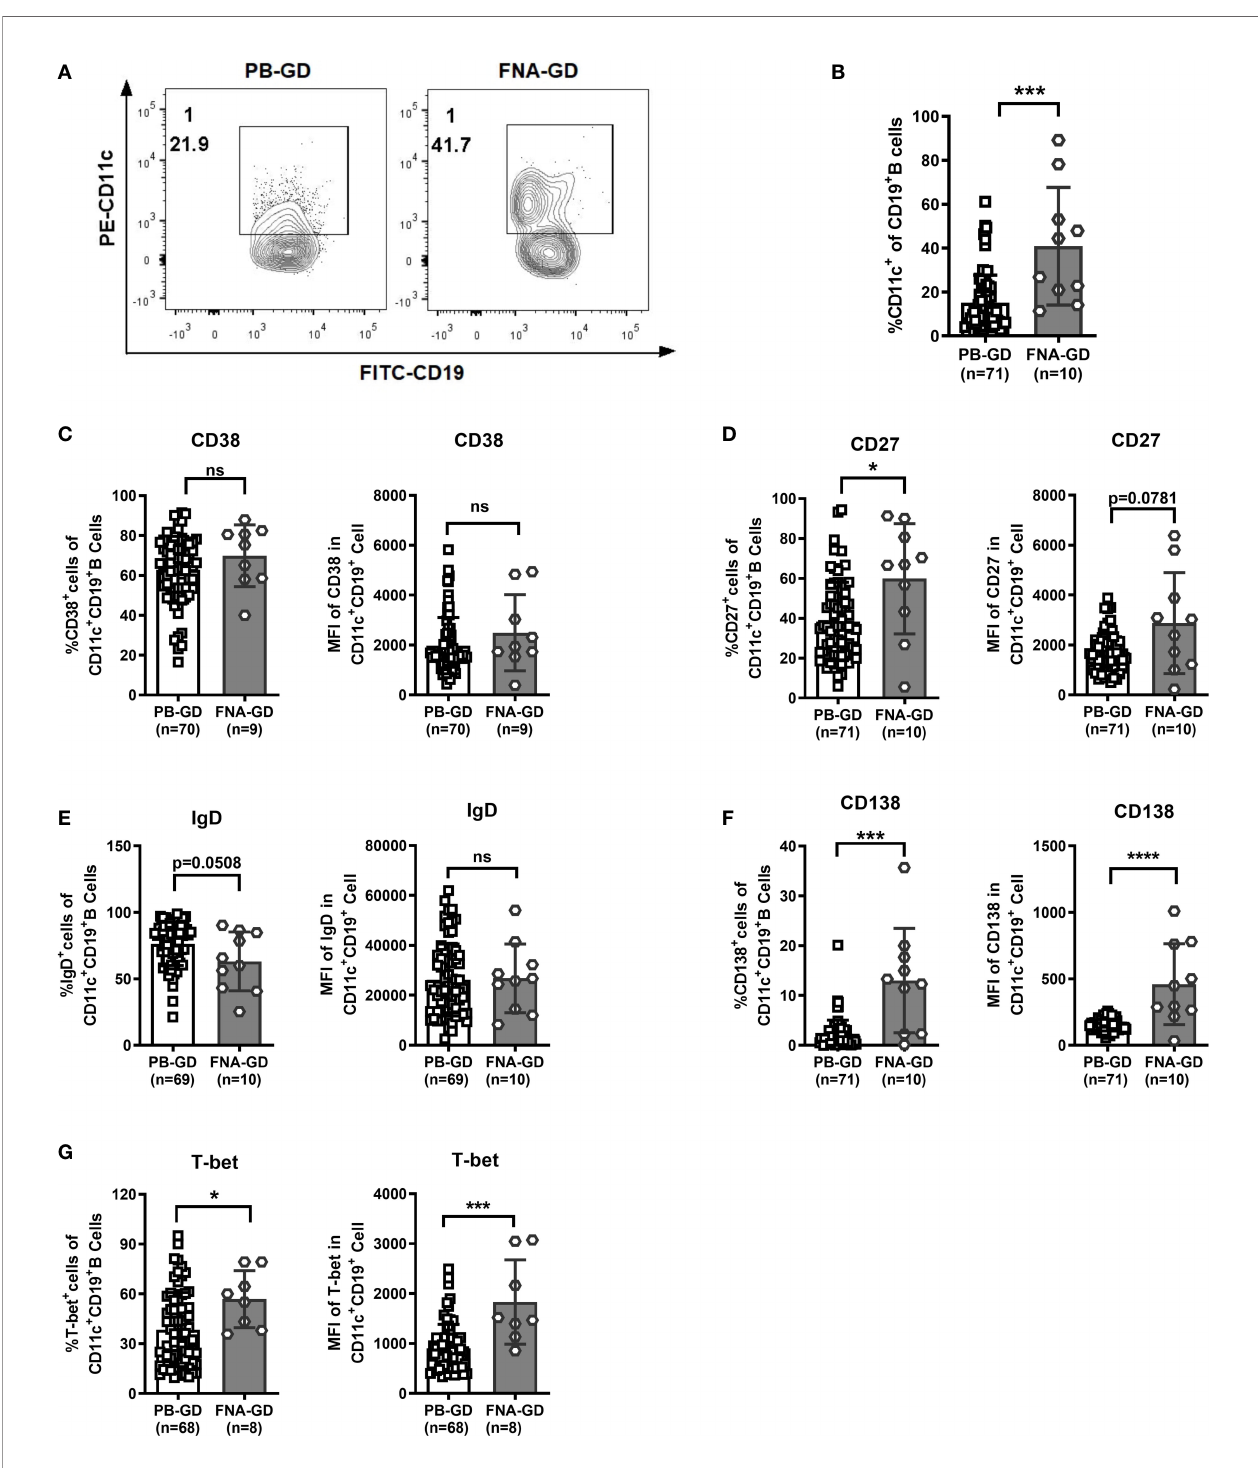
FIGURE 6 | Comparison of CD11c + B cells between peripheral blood (PB) and fi ne-needle aspiration (FNA) samples from GD patients. (A) Representative fl ow cytometric plots of CD11c + B cells in PB and FNA samples from GD patients. (B) Frequency of CD11c + B cells in CD19 + B cells for PB and FNA samples from GD patients. (C – G) Comparison between the frequency of the positive cell subset in PB CD11c + B cells and that in FNA CD11c + B cells (left). Comparison between the mean fl uorescence intensities (MFIs) of the representative phenotype in PB CD11c + B cells and that in FNA CD11c + B cells (right). The comparison metrics included conventional antigens (CD38, CD27, IgD, and CD138) and an unconventional antigen (T-bet). Nonnormally distributed data are expressed as the median and IQR, assessed by nonparametric Mann – Whitney U tests. P < 0.05 was considered statistically signi fi cant. ns, not signi fi cant; * P < 0.05; *** P < 0.001; **** P <